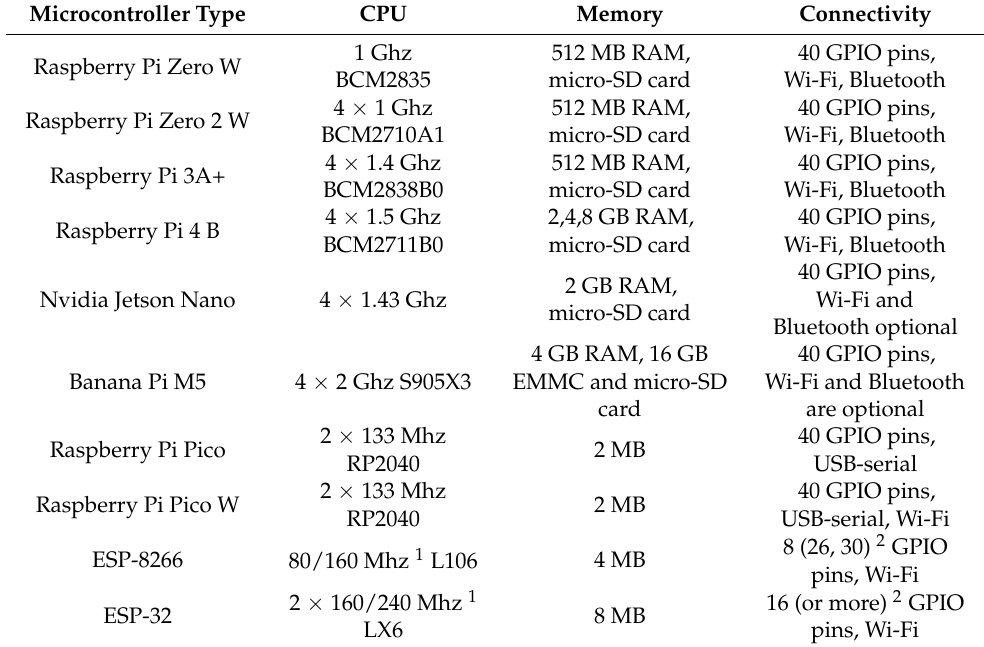
Table 1. List of